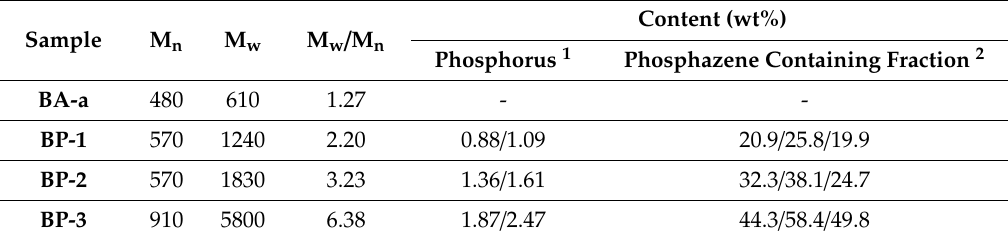
Table 3. Molecular weight characteristics and composition of phosphazene-containing benzoxazines.